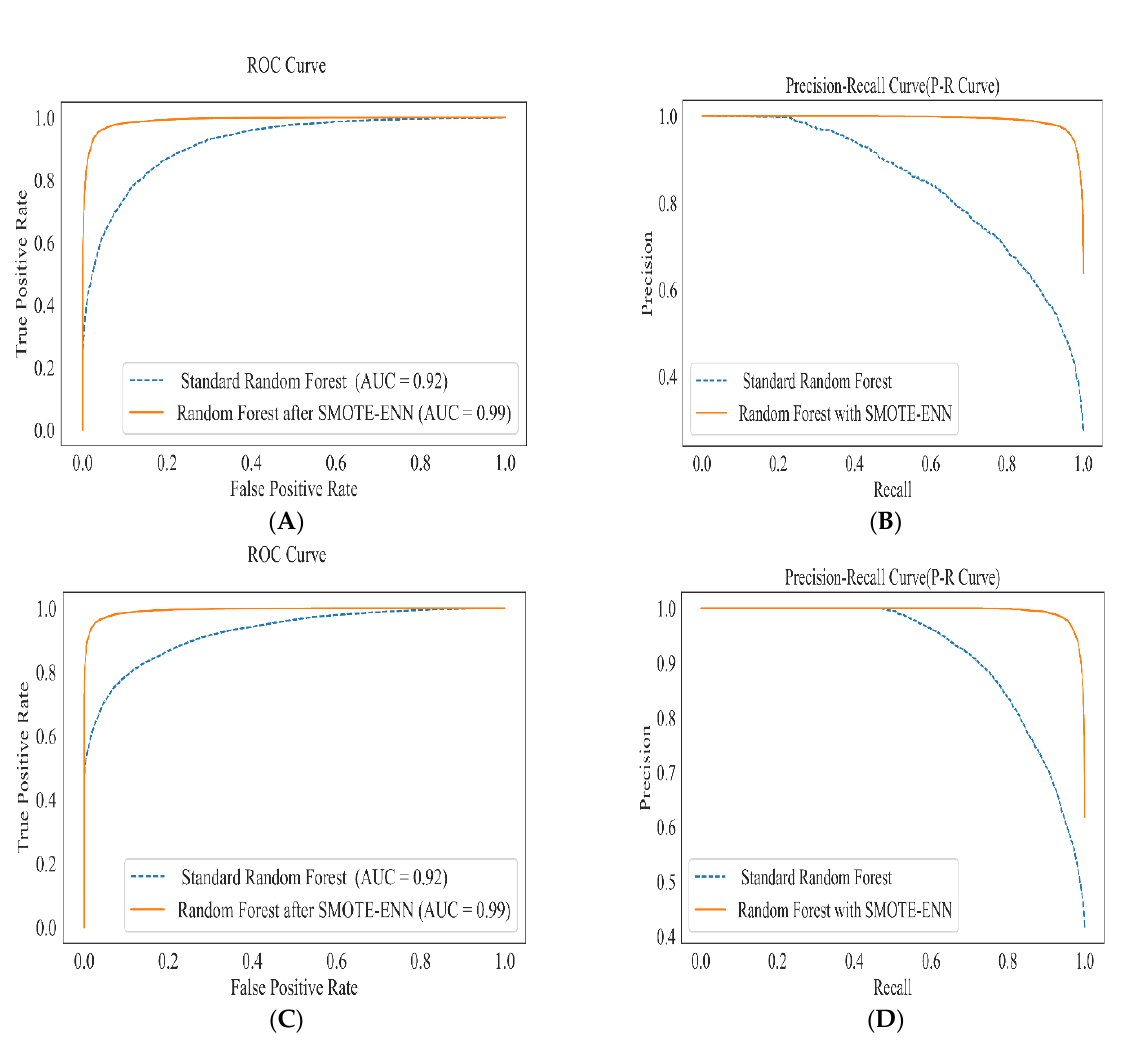
Figure 6. ROC-AUC and PR-curve analysis of H1 and H2 hotels.